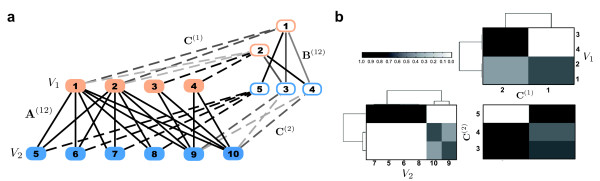
Illustration of the cluster decomposition of a bipartite toy example. (a) We demonstrate the graph decomposition with our algorithm on a small bipartite graph with overlapping cluster structure. The original graph consists of partitions V1 = {1 ... 4} (red filled nodes) and V2 = {5 ... 10} (blue filled nodes) connected by edges A(12) colored in black. We decomposed it into two clusters for partition V1 and three clusters for partition V2. The resulting fuzzy clustering is illustrated as a weighted graph connecting original nodes to cluster nodes (framed red and blue). The cluster assignments C(1) and C(2) are indicated by dashed lines, where the coloring corresponds to the degree of cluster membership. The interconnections of the clusters form the backbone graph, encoded in the adjacency matrix B(12) which we denote by continous lines where color indicates the edge weight.Another way of illustrating the graph decomposition is shown in (b). It is clearer especially for larger graphs. First, we plot hierarchical clusterings of the nodes' degrees of membership in partitions V1 and V2 (encoded by C(1) and C(2)). This facilitates the identification of overlapping clusters (e.g. nodes 1 and 10 are assigned to more than one cluster) or hard cluster assignments (e.g. node 5). The backbone graph B(12) is shown bottom right. This backbone graph is densely connected in our example.